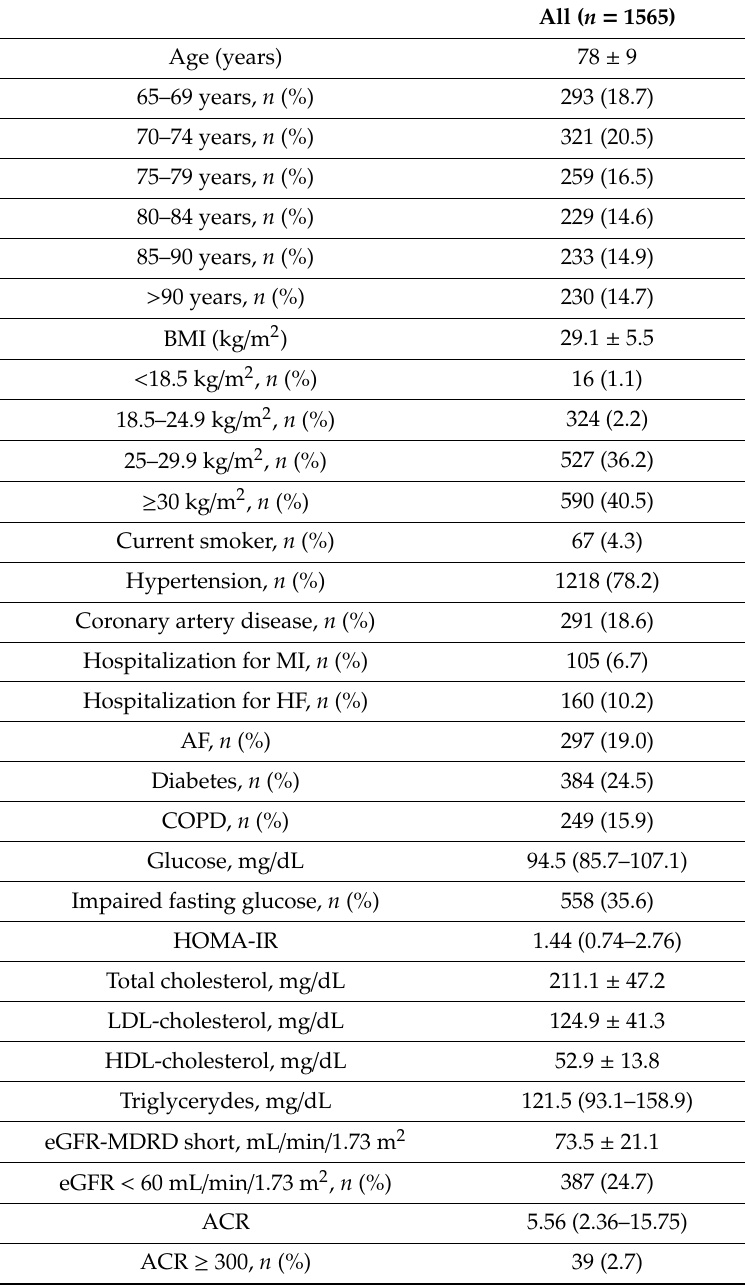
Table 1. Characteristics of the study population according to age, medical conditions, biochemical parameters and medication used. Data are provided as mean ± standard deviation (SD ) , median (1–3 Q) or numbers